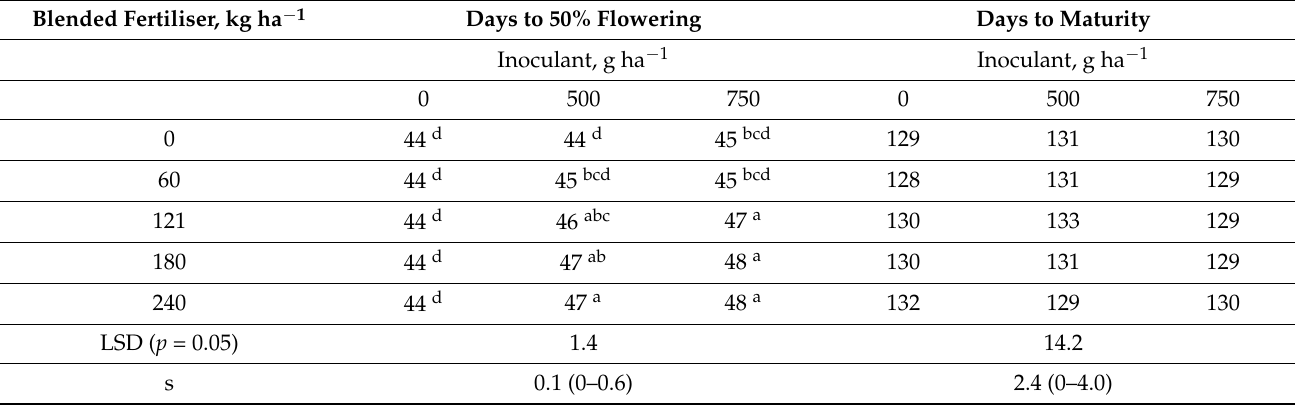
Table 5. Days to 50% flowering and days to maturity of faba beans that received different amounts of a blended chemical fertiliser and the Rhizobium